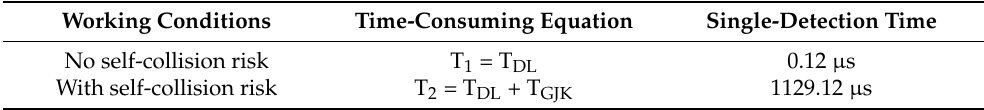
Table 5. Single self-collision detection time of